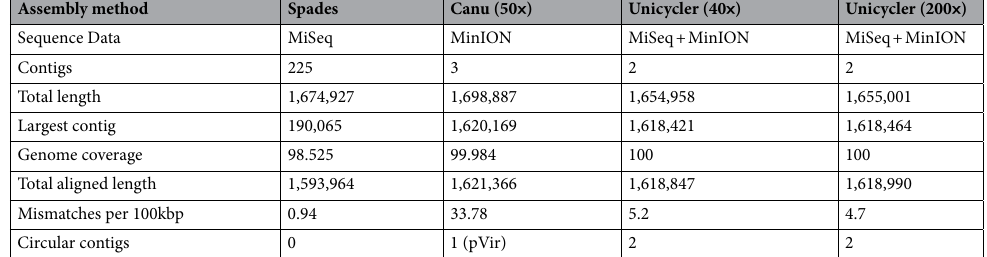
Table 4. C. jejuni 81-176 Assemblies. Genomes for C. jejuni reference strains 81-176 were assembled using SPAdes, Canu, or Unicycler and compared to the reference genome using QUAST. The MinION data was filtered to an estimated coverage of 40 × , 50 × , or 200 × using a genome size of 1.7